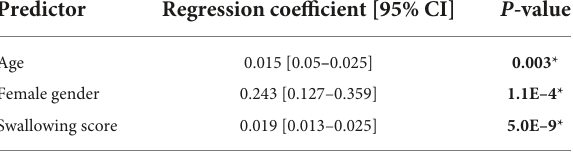
TABLE 2 Predictors of reduced nutritional